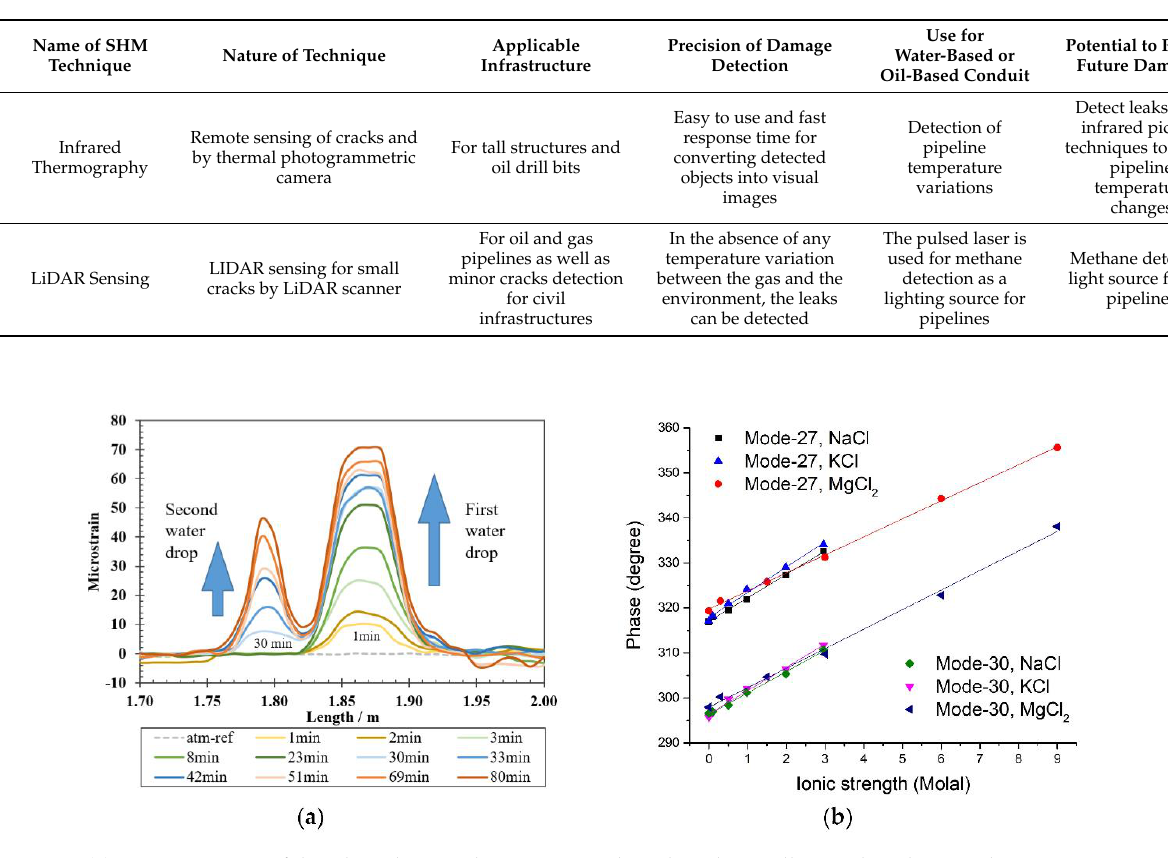
Figure 13. ( a ) Demonstration of distributed water detection in air based on the swelling-induced strain changes interrogated with an optical backscatter reflectometer (OBR). The first water drop was added at 1 min, and the second water drop was added at 30 min [71]; ( b ) Phase shift-based optical fiber sensor (OFS) without any additional coating for simultaneous multi-parameter monitoring including ionic strength as a corrosivity indicator [71].